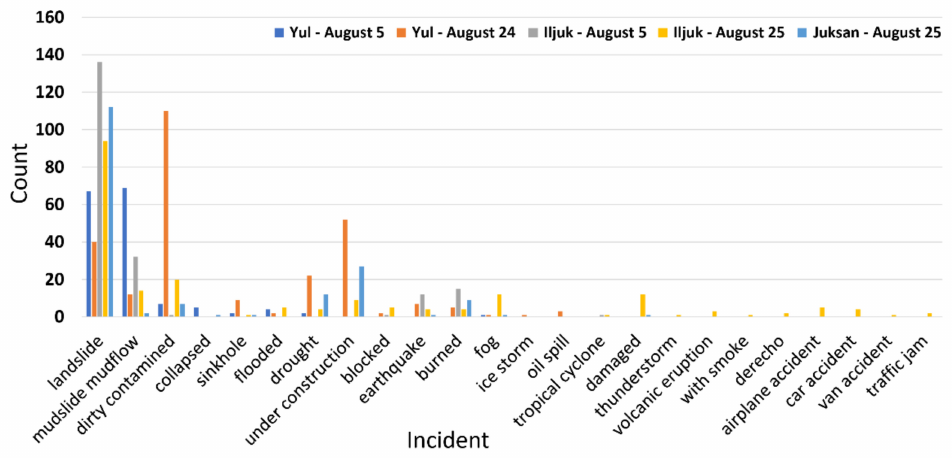
Figure 5. Number of images with confidence score over 0.5 for top-1